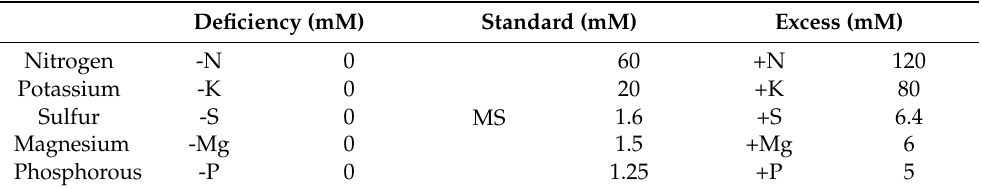
Table 1. Nutrient concentration (N, K, S, Mg, and P) for each treatment (a deficiency, standard, and